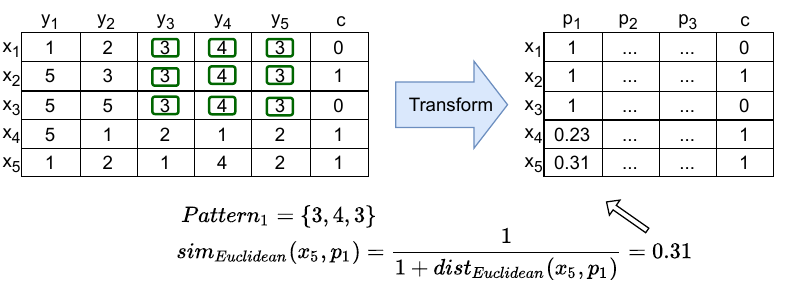
Figure 6. Pattern-centric transformation to map time series data onto multivariate data, obtained by comparing end-users against the found